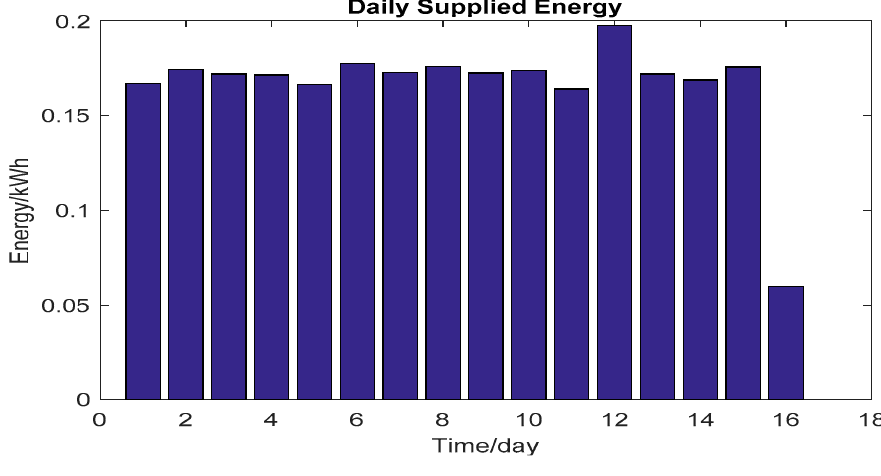
Figure 24. Daily supplied